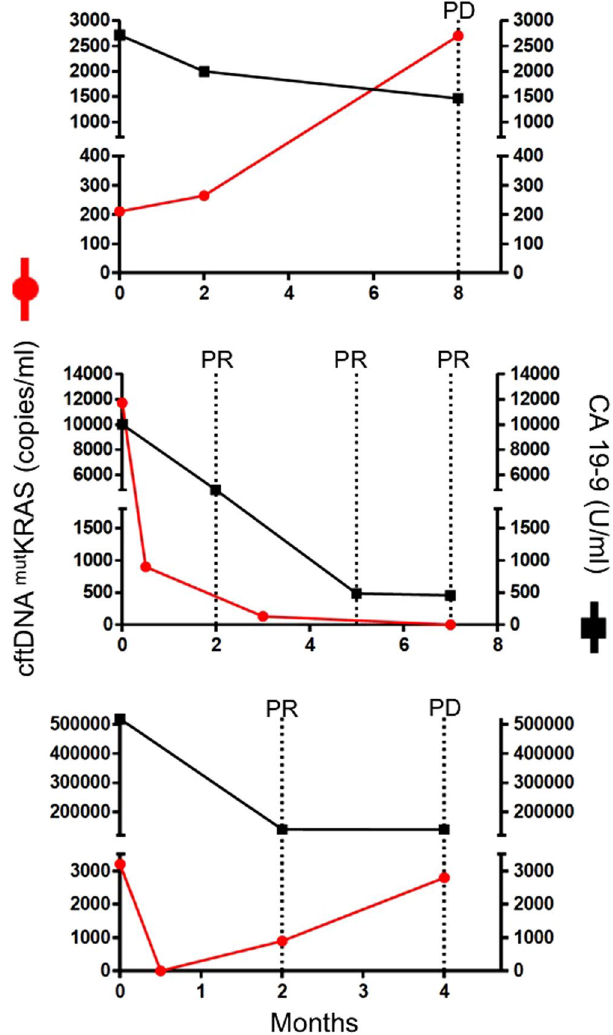
Figure 4. Changes in cftDNA mut KRAS levels compred to CA 19-9 in a case of early PD (upper panel), PR (middle panel) and early PR followed by PD (lower